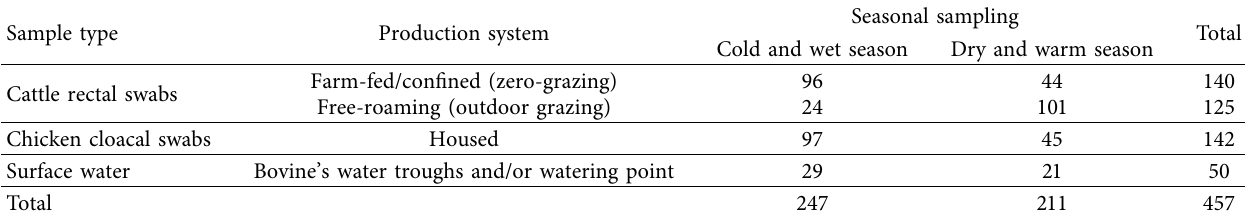
Table 1: Sampling types and distribution per season under different production